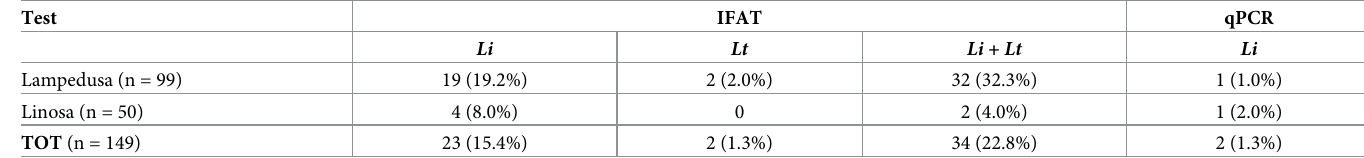
Table 2. Number and prevalence of dogs positive to L . infantum ( Li ) and/or L . tarentolae ( Lt ) by IFAT and qPCR based on the geographical